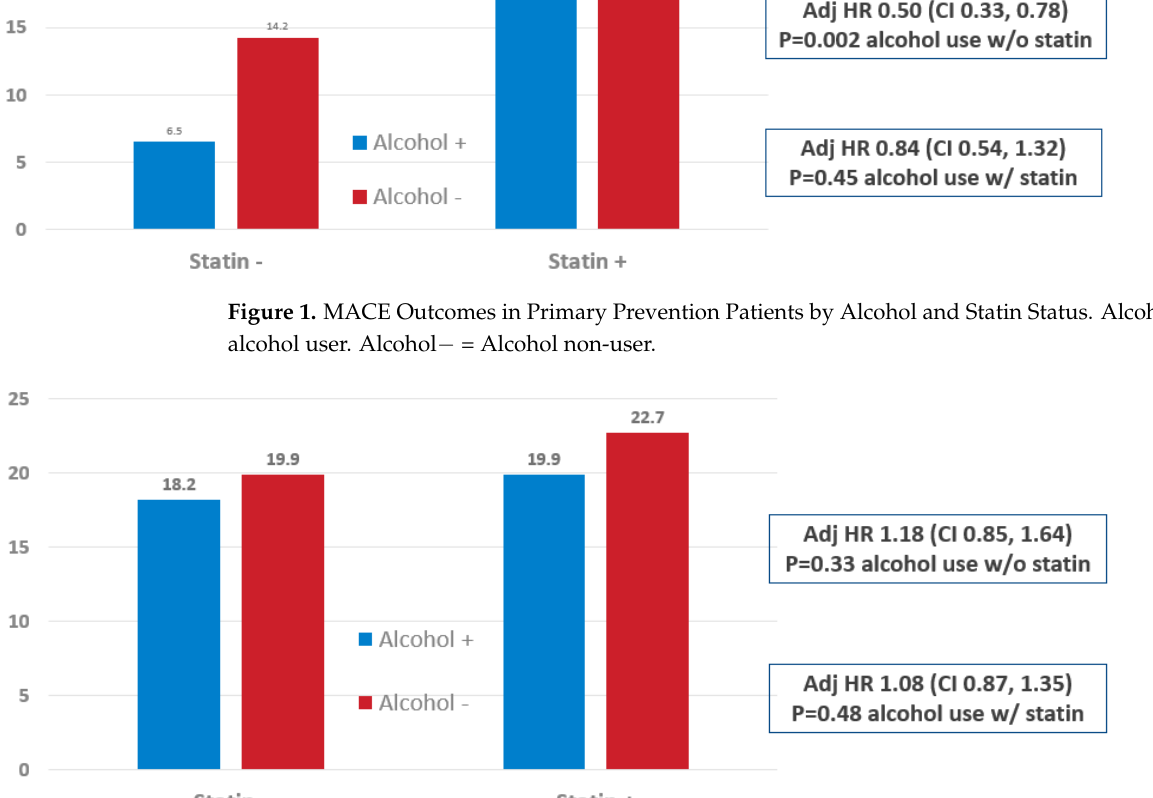
Figure 2. MACE Outcomes in Secondary Prevention Patients by Alcohol and Statin Status. Alco- hol+ = alcohol user. Alcohol − = Alcohol non-user. = alcohol user. Alcohol − = Alcohol